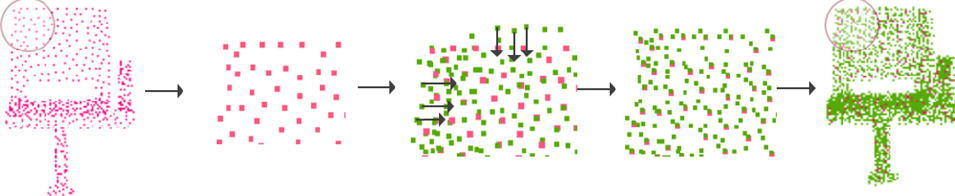
Figure 7. Preserve the boundaries of the chair. The red point cloud indicates the original point cloud, and we can see the boundary of the chair by magnifying the circle part clearly. However, the green point cloud produced by the previous algorithm blurs the boundary. We pull back the green points that are beyond the boundary to keep the boundary of the chair.